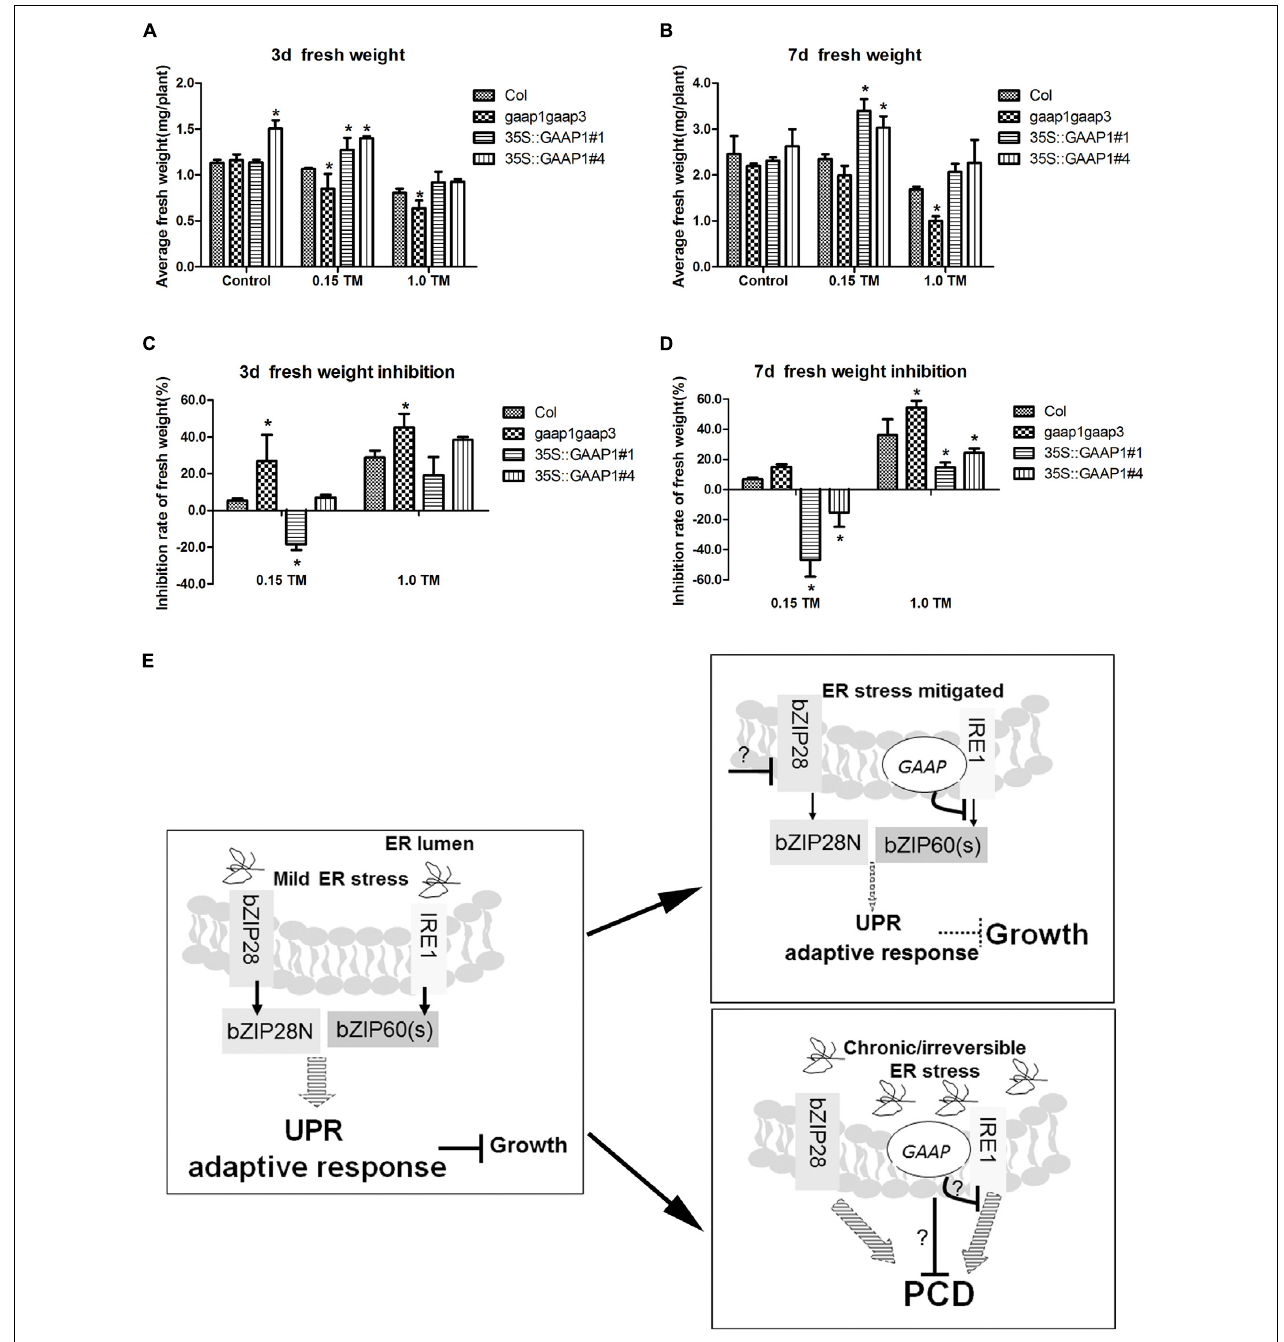
FIGURE 8 | GAAP1/GAAP3 promoted growth recovery after mild ER stress was relieved and the working model of the function of GAAP1/GAAP3. (A–D) The 4-day-old seedlings that were infiltrated with 1/2 MS liquid salt containing 0, 0.15, and 1.0 µ g mL − 1 TM for 6 h were transferred to the 1/2 MS solid medium. Fresh weight of seedlings (A,B) and inhibition rates (C,D) were determined after recovery for 3 and 7 days. Data are from three biological replicates ( ± SE) and at least 30 samples for each plant line were used for each treatment. Asterisks refer to significant differences from Col at the same time points and same conditions ( t -test; p < 0.05). (E) Working model of the dual role of GAAP1/GAAP3 in the regulation of UPR and PCD. In cells undergoing mild ER stress, rapid adaptive responses were initiated through UPR signaling mediated by bZIP28 and IRE1 at the cost of growth inhibition. Usually the weak inhibition role of the low level of GAAP1/GAAP3 in vivo under such condition makes cells increases the competence for UPR signaling. The artificial ectopic expression GAAP1/GAAP3 will postpone the activated UPR signaling. GAAP1/GAAP3 level will be upregulated upon ER stress and then down-regulated upon UPR signaling by inhibiting IRE1 activity to soon recover plant growth when the ER stress is mitigated. GAAP1/GAAP3 negatively controls IRE1 activity via direct association. If the ER stress is persistent or severe, PCD will be induced. GAAP1/GAAP3 might regulate the downstream PCD machinery or negatively control IRE1, thereby inhibiting cell death initiated by diverse intrinsic death stimuli, including irreversible ER